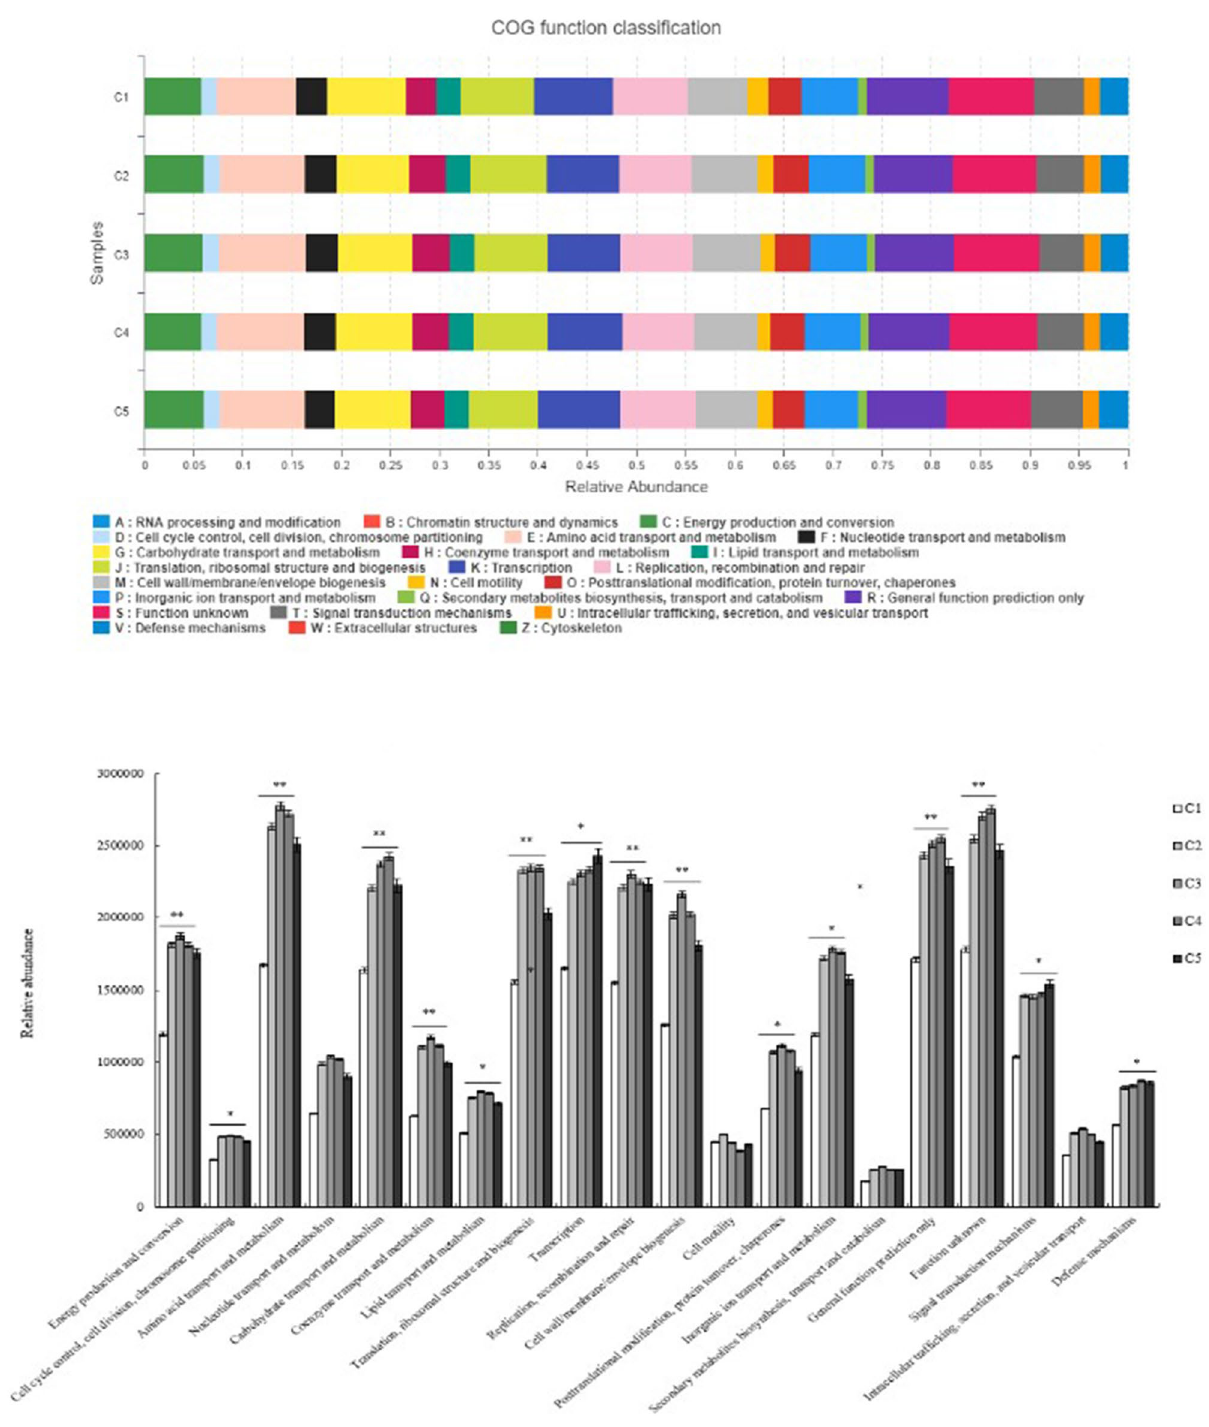
Figure 4. Function classification based on bacterial composition. ( a ) KEGG pathway function classification. KEGG is a database resource that integrates genomic, chemical and systemic functional information 25 . STAMP software was applied to detect the differentially abundant Kyoto Encyclopedia of Genes and Genomes (KEGG) pathways among groups with false discovery rate correction. ( b ) One-way ANOVA analysis between bacterial composition and function. *P < 0.05, **P < 0.01. ( c ) Relative abundance of pathogen in One-way of ANOVA analysis of KEGG pathway function classification caused by pathogenic bacteria. Superscript capital letters in the same color of column and in the same experimental duration mean P < 0.01. The one-way ANOVA analysis was performed by post hoc tests. The Microsoft Office Excel 2010 was used to as the stamp